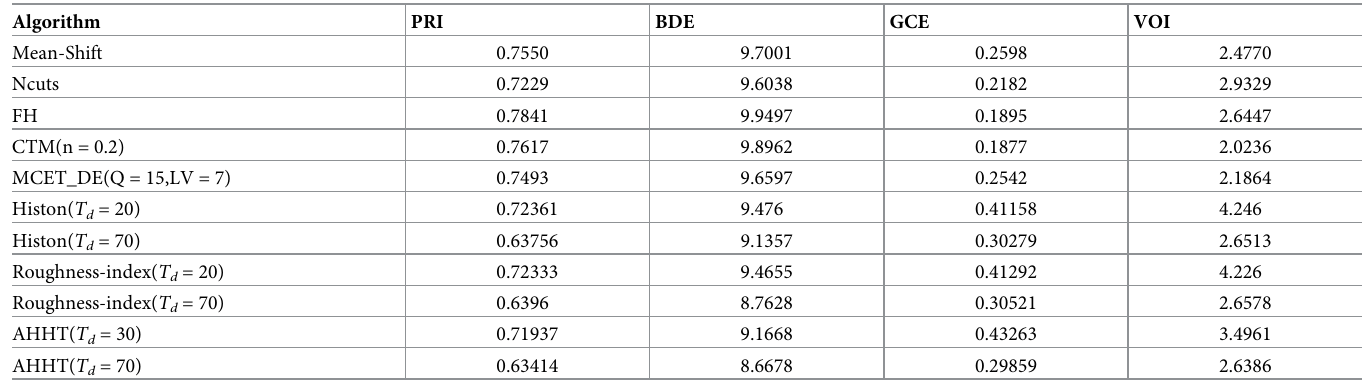
Table 5. Comparison averages of PRI, BDE, GCE and VOI on BSDS300.